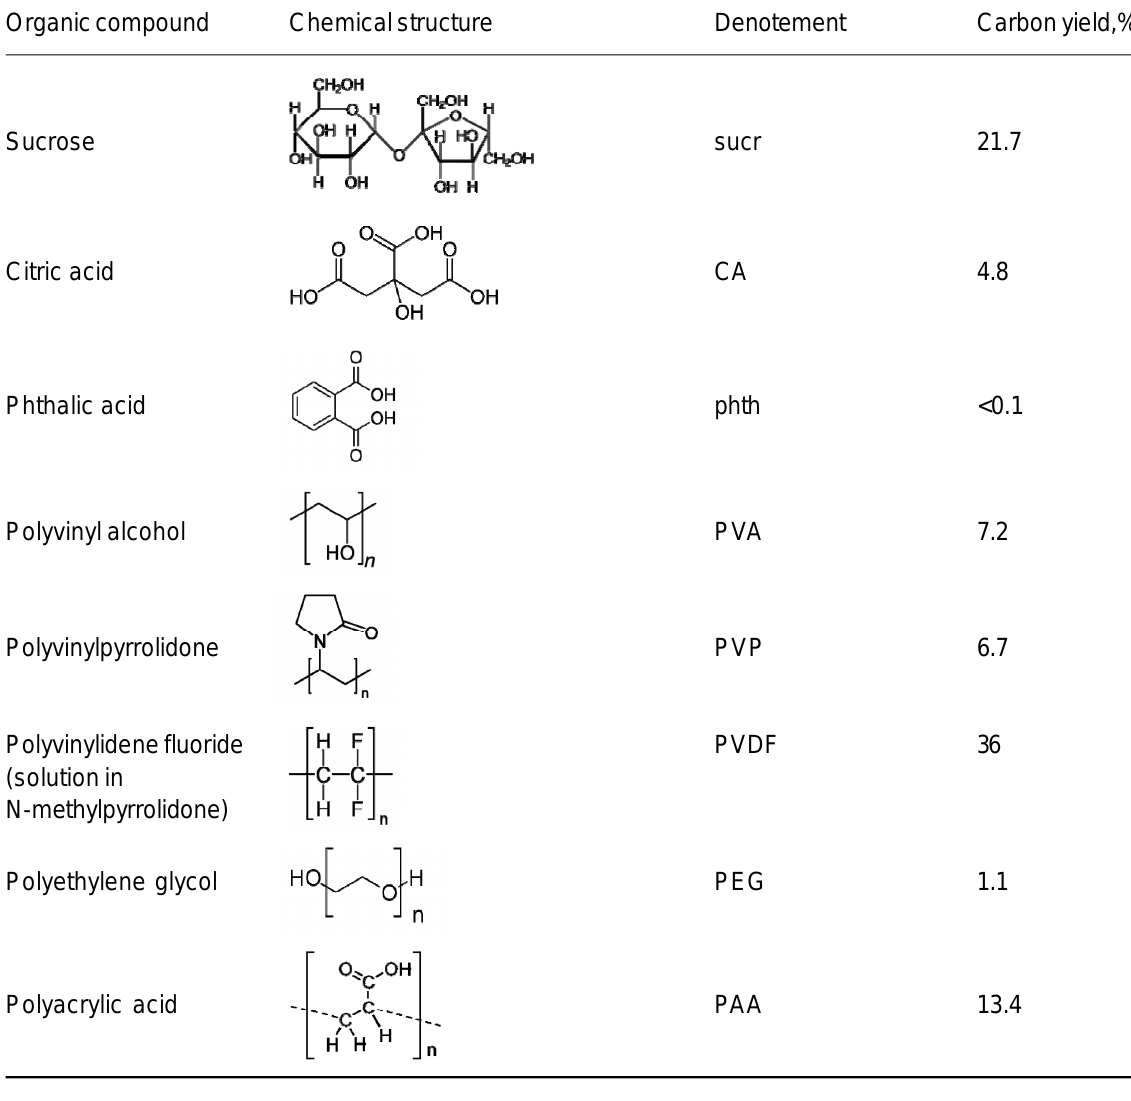
Table 1. Chemical structures and short denotements of the organic compounds used as carbon sources, and weight of carbon residues related to the weight of the organic carbon sources (wt.%) compound